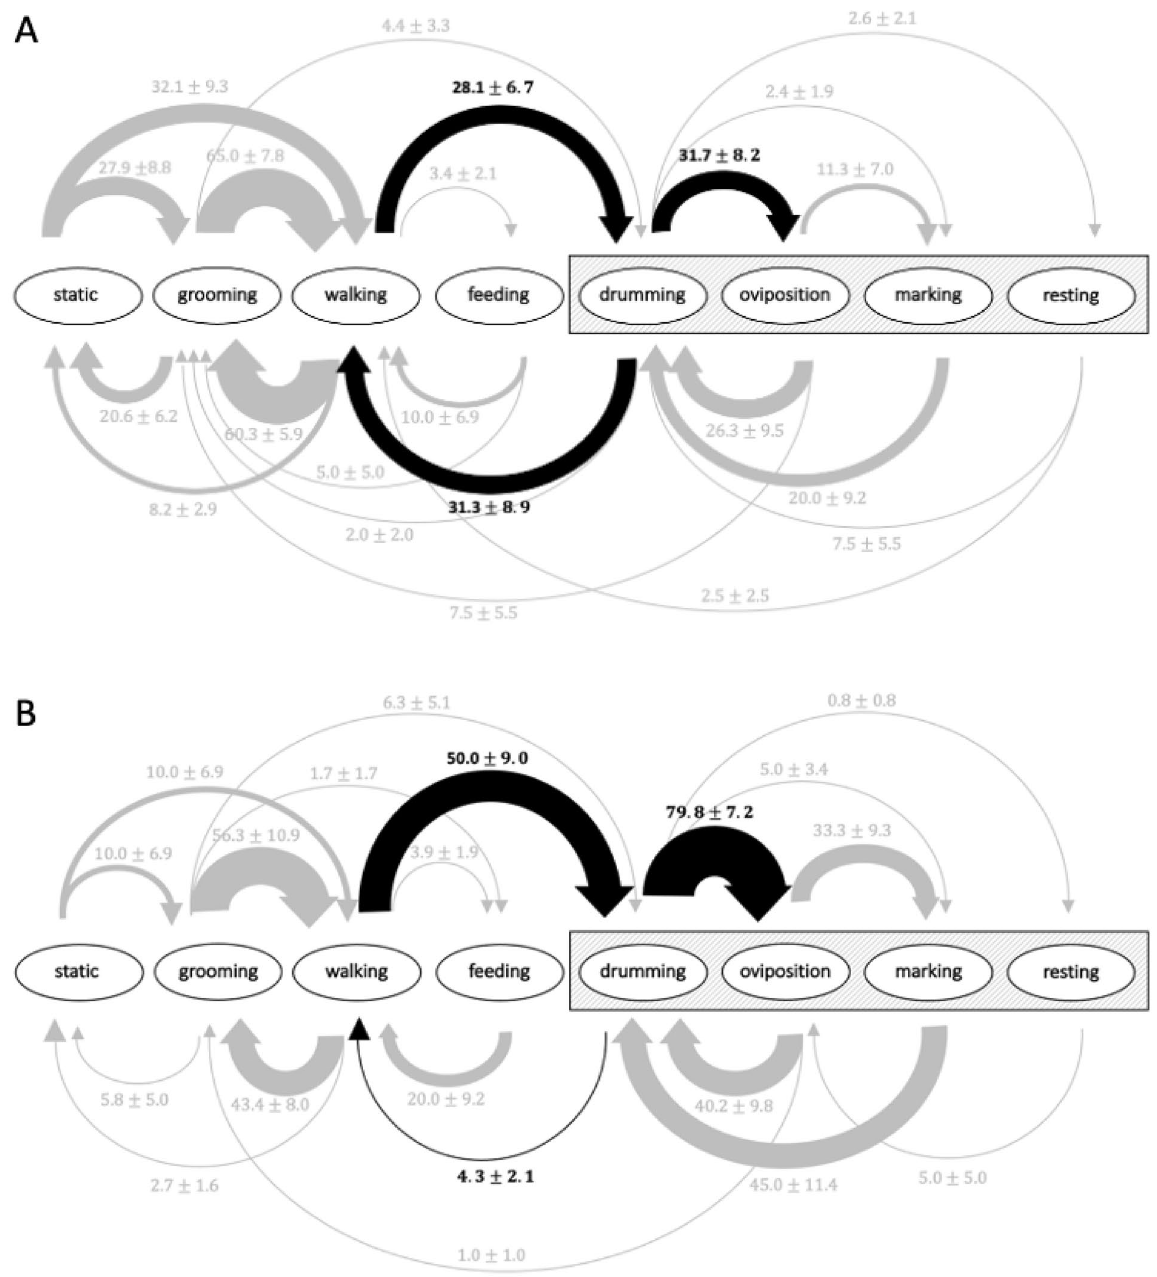
Figure 4. Ethogram of the proportion of transitions between behavior states (mean ± SE) within a 30 min period by H. pennsylvanicus female when provided L. zonatus host eggs and fed a water ( A ) or honey-water diet ( B ). Grey box highlights behaviors in which parasitoid is interacting with host eggs. Line thickness indicates relative frequency of transition. Black arrows highlight behaviors where a statistical difference was observed between the two treatments ( P < 0.05; GLM and likelihood ratio chi-squared